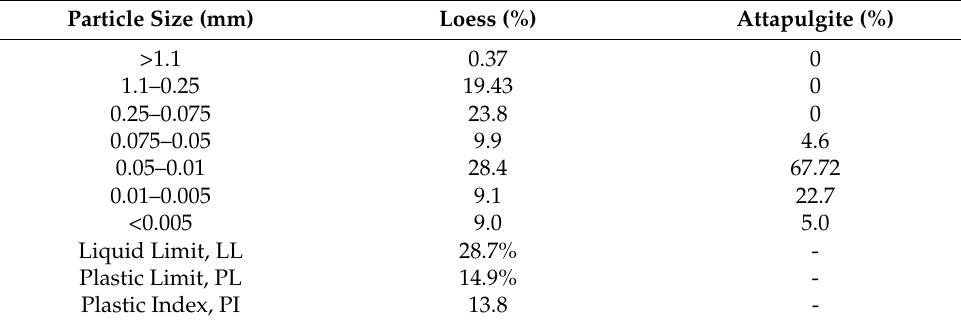
Table 1. The basic physical properties of loess and attapulgite.